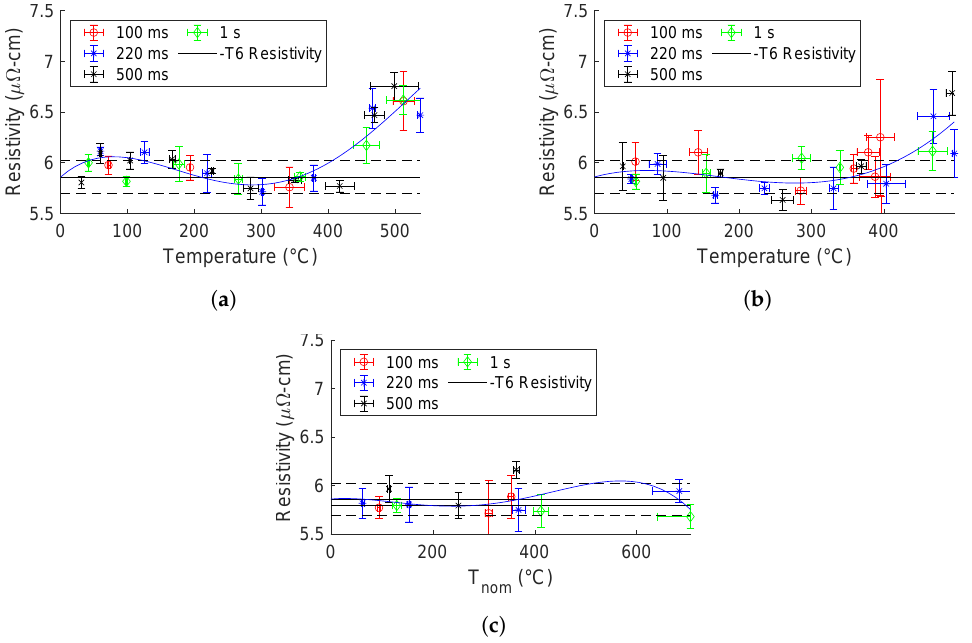
Figure 15. DC test results of ex situ resistivity measurements; Dashed black lines represent a single standard deviation of the -T6 baseline resistivity; ( a ) Air-cooled, air-quenched, ( b ) air-cooled, water- quenched, ( c ) water-cooled, water-quenched, temperature values are